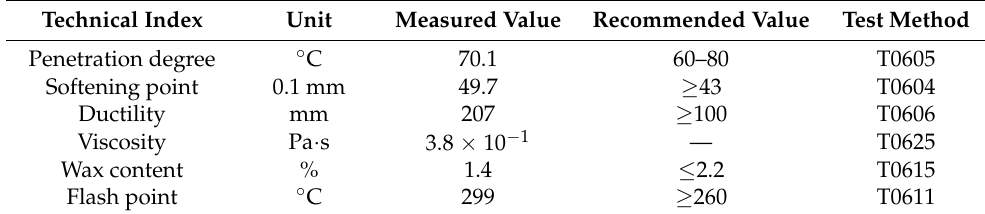
Table 3. Basic performance index of the original asphalt.